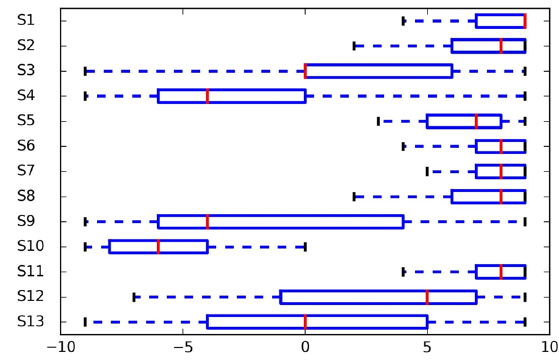
Figure 2. Views on PV by Kenyan (semi-)experts. In the boxplots the median is represented by a red line, the first and third quartiles form the edges of the box and the whiskers extend from the hinges of the box to the 5 th and 95 th percentiles.